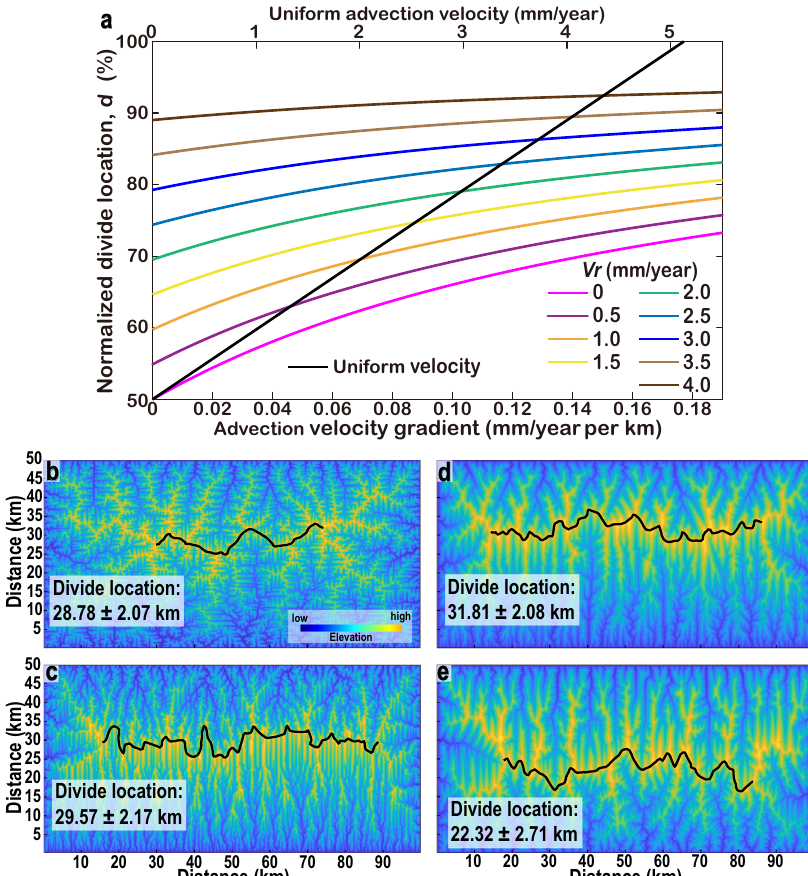
Fig. 3 Divide response to advection. a Relationship between advection velocity and normalised divide location. V r is the velocity at the edge of the negative side. b No advection. Uplift rate increases linearly from the bottom edge of 0.5 mm/year to 1 mm/year at the top edge, with an uplift gradient of 0.01 mm/ year per km. This simulation belongs to the 20 numerical models in Fig. 2e. c Uniform uplift rate of 0.5 mm/year. Advection towards the top side, and advection velocity decreases linearly from the bottom edge of 1 mm/year to 0.5 mm/year at the top edge, with a velocity gradient of 0.01 mm/year per km. d Uplift gradient and advection push the divide in the same direction. Uplift rate increases linearly from the bottom edge of 0.5 mm/year to 1 mm/ year at the top edge, with an uplift gradient of 0.01 mm/year per km. Advection towards the top side, and advection velocity decreases linearly from the bottom edge of 1 mm/year to 0.5 mm/year at the top edge, with a velocity gradient of 0.01 mm/year per km. e Uplift gradient and advection push the divide towards different directions. Uplift rate increases linearly from the bottom edge of 0.5 mm/year to 1 mm/year at the top edge, with an uplift gradient of 0.01 mm/year per km. Advection towards the bottom side, and advection velocity decreases linearly from the top edge of 1 mm/year to 0.5 mm/year at the bottom edge, with a velocity gradient of 0.01 mm/year per